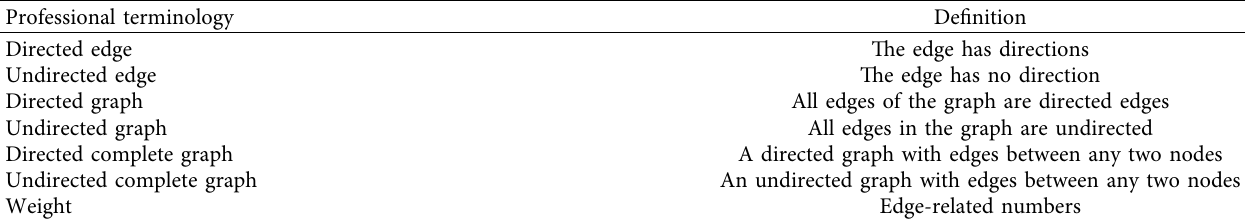
Table 1: Basic concepts of